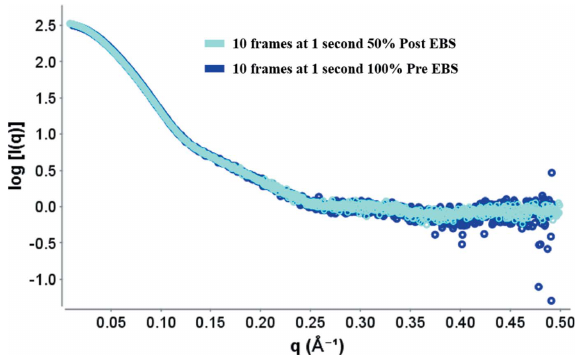
Figure 9 Intensity ( I ) versus scattering vector ( q ) for protein BSA pre- and post- ESRF–EBS. Each sample contained 5 mg ml (cid:6) 1 of BSA in 50 m M Hepes buffer pH 7.5. Dark blue: 100% transmission pre-EBS in a capillary of